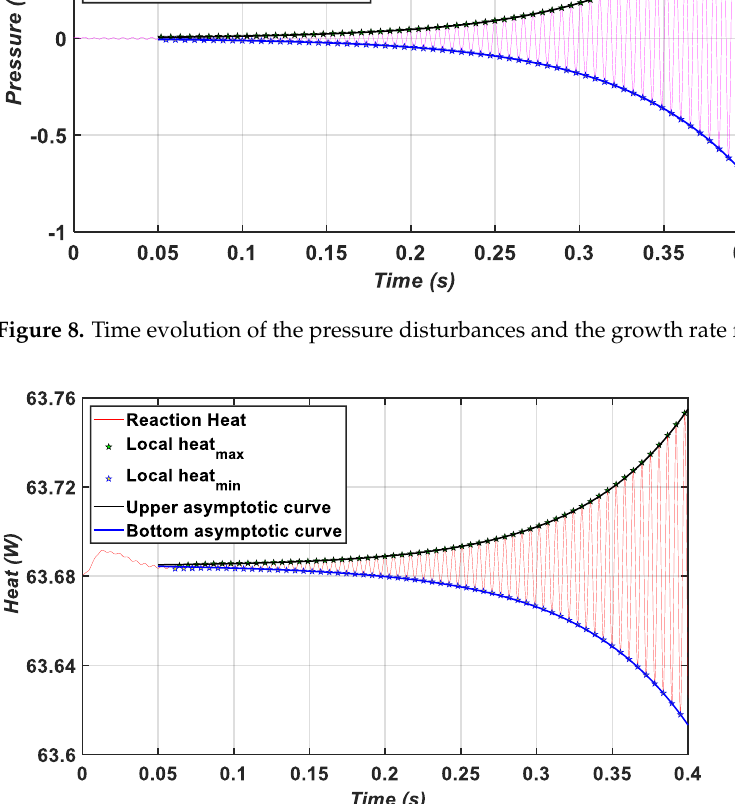
Figure 9. Time evolution of the unsteady heat release and the growth rate fitting curve.